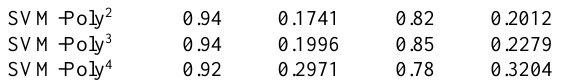
Table 2: R and RMSE values of ANN and SVM models on training and test data.